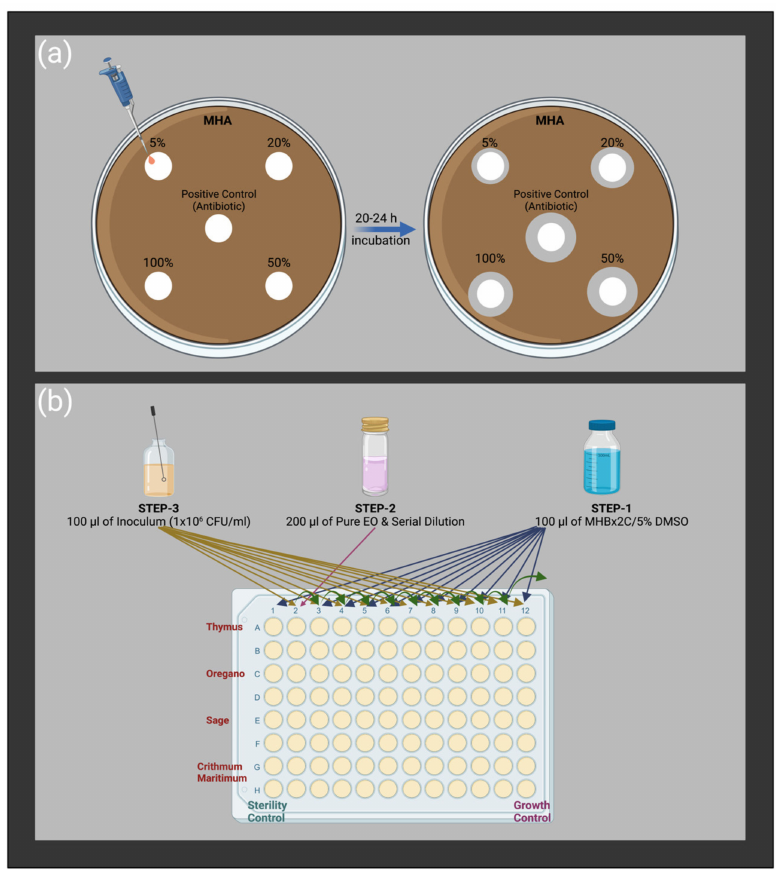
Figure 3. Schematic illustration of the experimental procedure of ( a ) disc diffusion and ( b ) broth microdilution